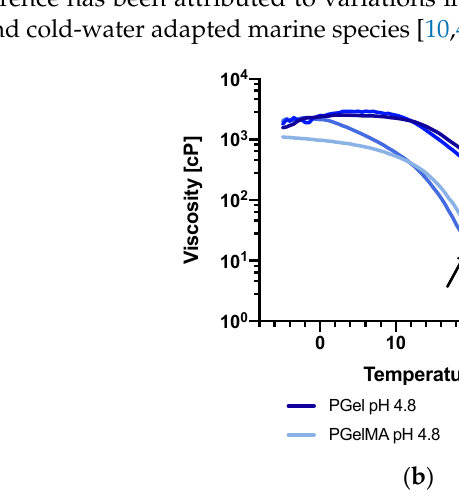
Figure 4. Flow temperature ramp (cooling) of gelatin suspensions (10% w / v ) at pH ~3.6 and 4.8. ( a ) SGel and SGelMA, ( b ) PGel and PGelMA. Arrows indicate the marked increase in viscosity for all suspensions.